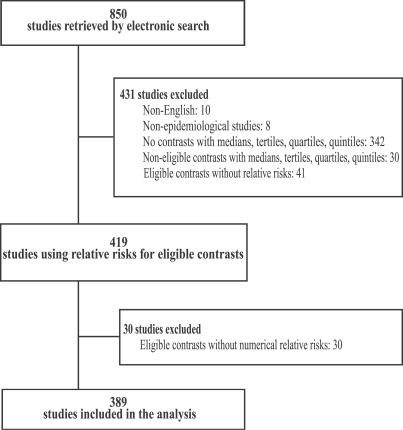
Flow Diagram for Studies Included or Excluded from the Analyses According to Eligibility Criteria